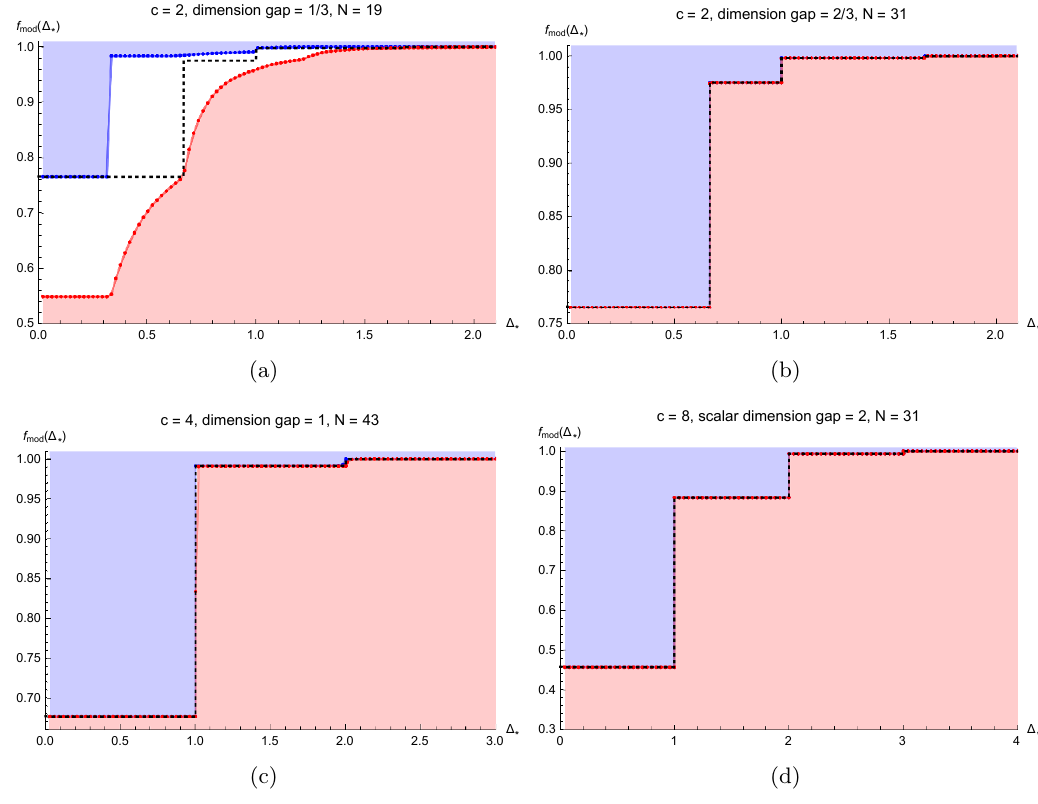
Figure 6 . The upper (blue) and lower (red) bounds on the modular spectral function. Top: the bounds for c = 2 with an assumed dimension gap one-half of (left) and equal to (right) the maximal gap allowed by modular invariance. Bottom: the bounds on the modular spectral function for c = 4 with the maximal dimension gap (left) and for c = 8 with the maximal gap in the spectrum of scalar primaries (right). In all cases, the dotted lines denote the modular spectral function for the corresponding extremal